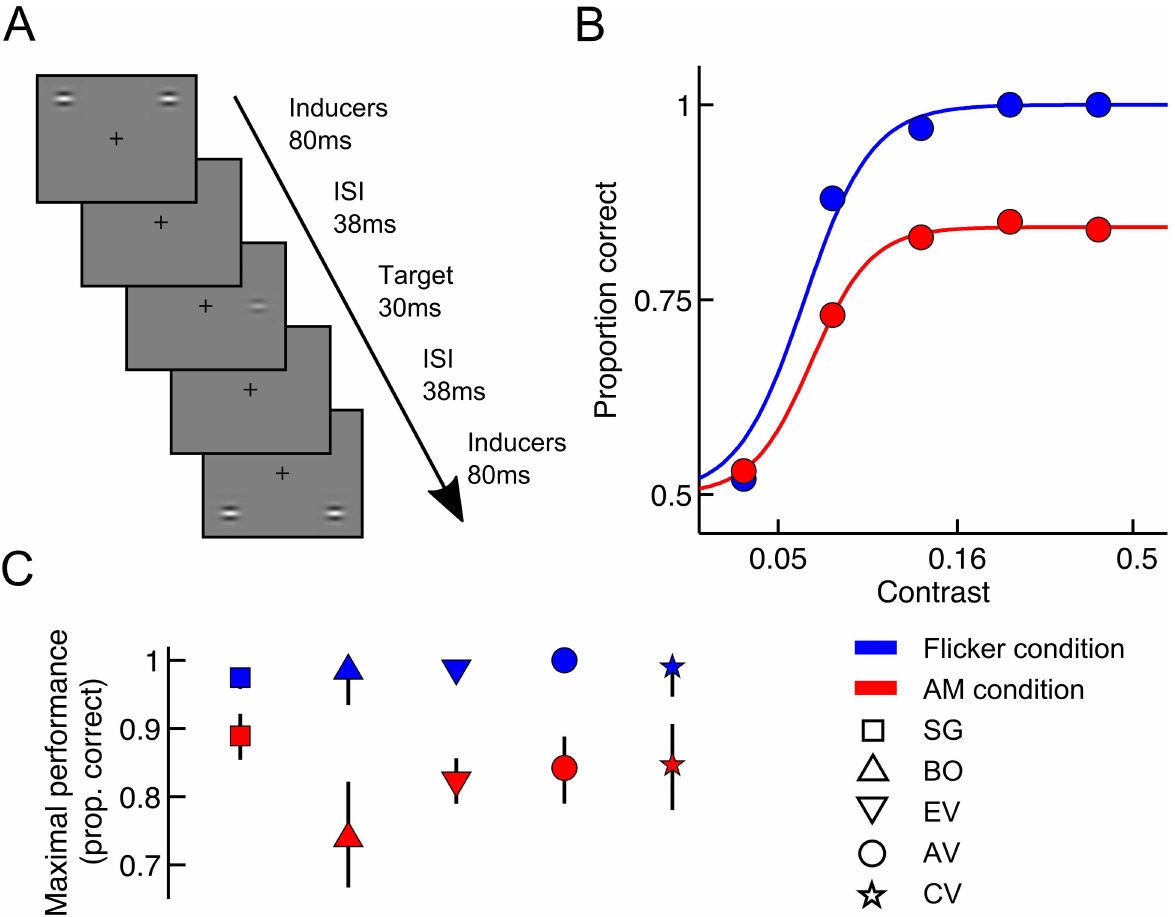
Fig 1. AM induces decreasedcontrast detection performance. (A) Illustration of part of the trial sequencein the AM conditionof the 2AFC task. The figure only shows the fourth sequence of AM during which the target grating was briefly presented.Contrast of the target grating has been increasedfor illustration purposes. (B) Maximum contrast detection performance of a typical observer (AV) is considerably lower in the AM condition(red) than in the Flicker condition(blue) when the orientationof the target grating and inducers is identical. Full lines depict the best-fitting logistic psychometric function. (C) Maximal detection performance (1 − λ ) is lower in the AM conditionthan in the Flicker conditionfor all observers. Symbols denote different observers. Error bars represent the 95% confidence